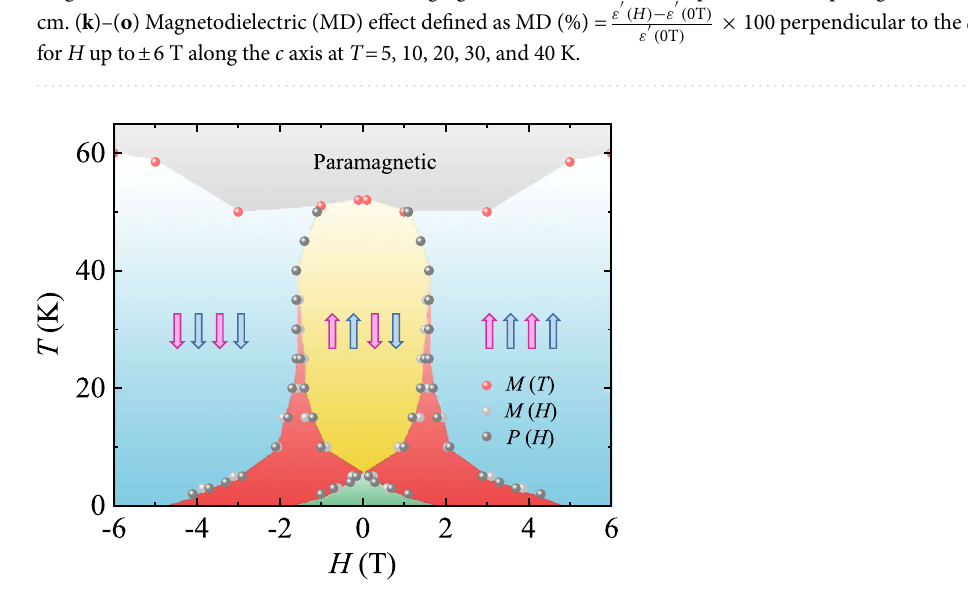
Figure 4. Phase diagram. The H - T phase diagram of the YCMO single crystal for H along the c axis, constructed from T dependence of M , and H dependence of M and P . In the red region, magnetic structure depends on the